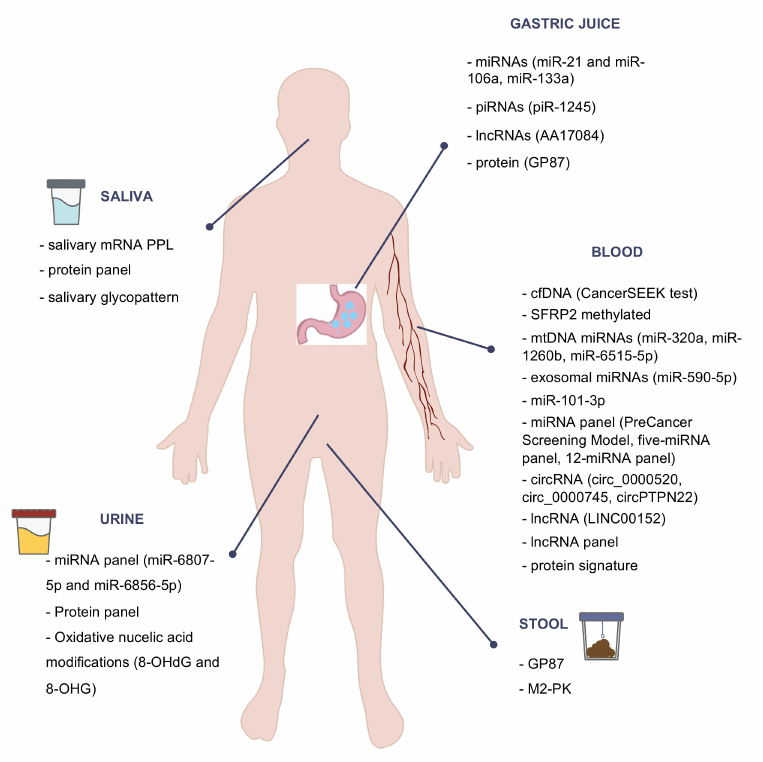
Figure 1. Scheme of some of the most important noninvasive biomarkers for gastric cancer diagnosis and